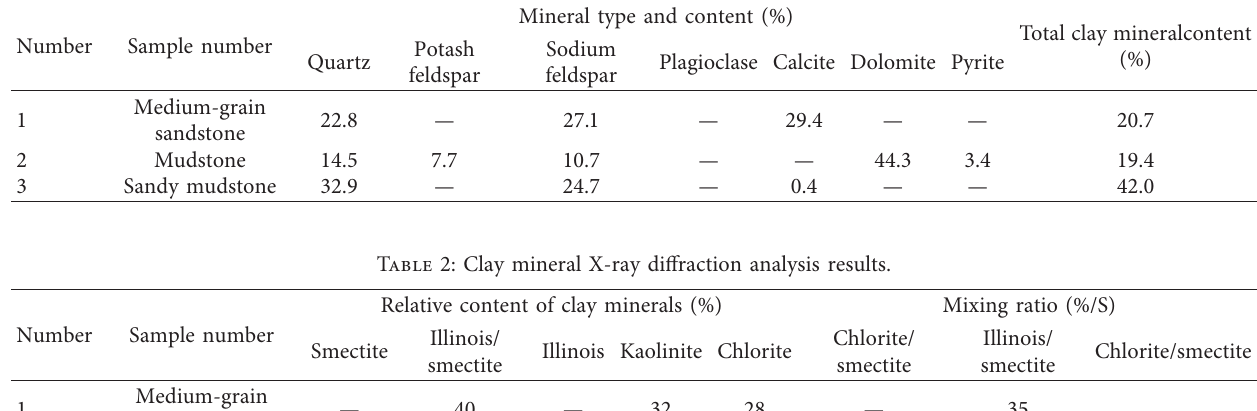
Table 1: Whole-rock mineral X-ray diffraction analysis.